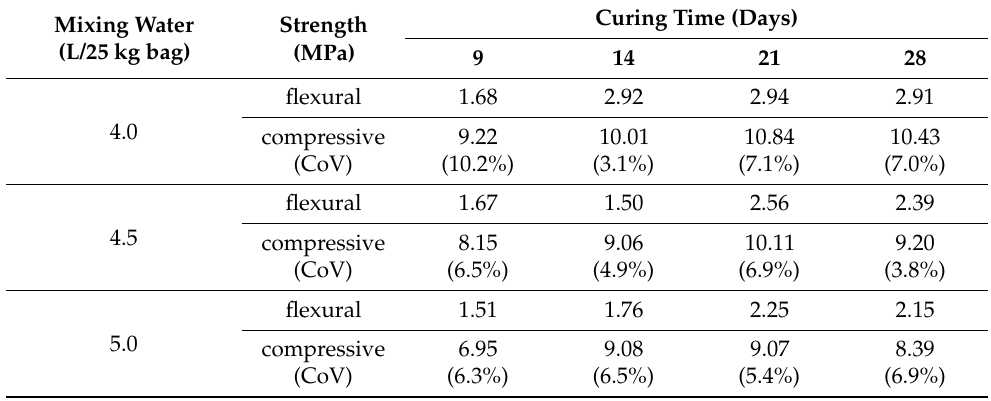
Table 1. Summary of mortar test results